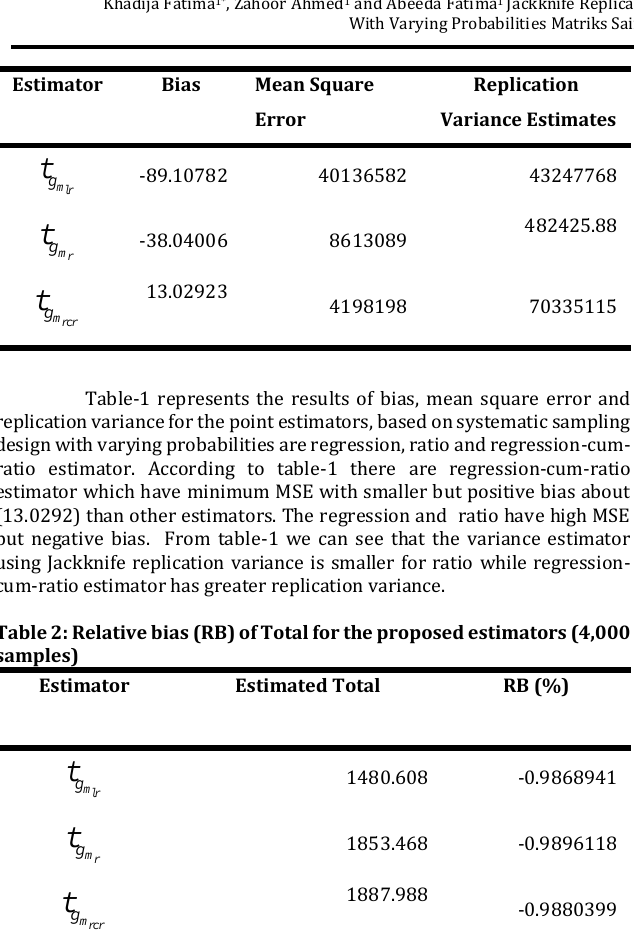
Table-2 shows the percent relative biases (PRB) of the eight types of estimators for total. All the biases are less than 1% in the absolute value and according to findings of relative biases all these estimators behave reasonably in term of point estimation. Table-3 represents the percent relative bias (PRB) of Jackknife variance estimator and confidence interval (C-I) for the proposed estimators. The results show that, regression estimator has smaller positive relative bias as compared to other estimators. On the other hand ratio having negative PRB. Table 3: Relative bias (RB) of Jackknife Variance Estimator and Confidence Interval (C-I) for the Proposed estimators (4,000 samples)